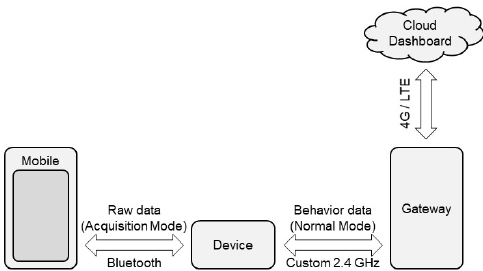
Figure 2. Schematic view of the communication system and the two operating modes (the acquisition mode on the left side and the normal mode on the right side).